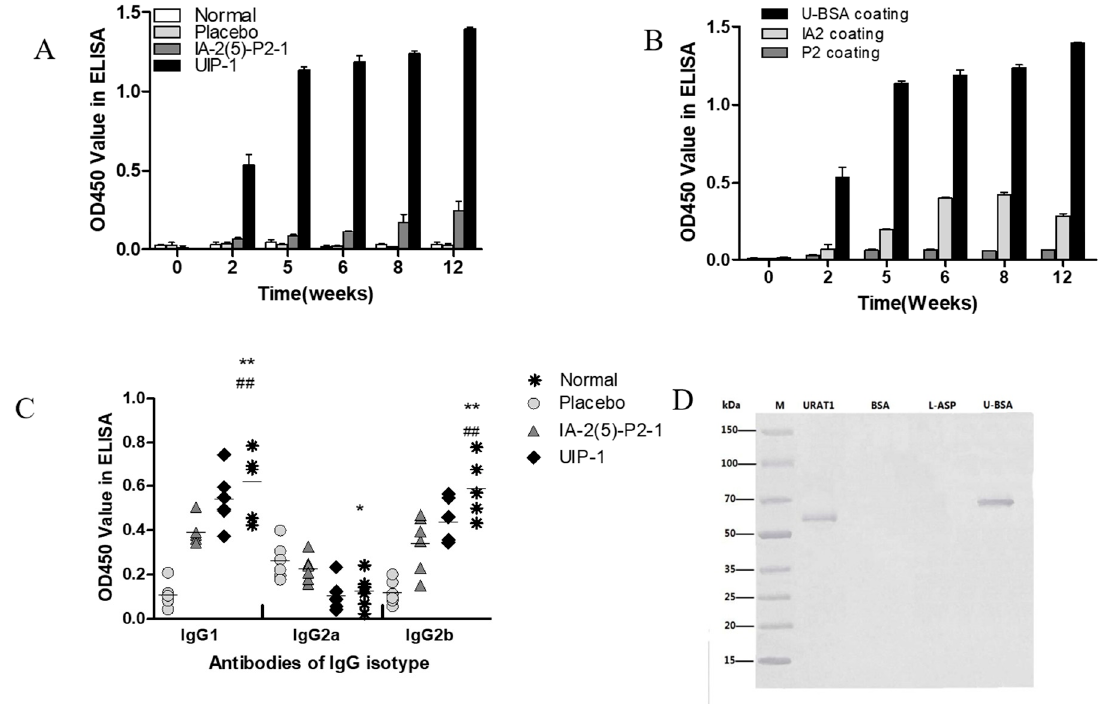
Figure 5. Induction of specific anti-URAT1 antibody after immunization in male C57BL/6J mice. ( A ) Male diabetic mice were immunized with UIP-1 ( n = 10), IA-2(5)-P2-1 ( n = 10), or Lipofundin ( n = 10), as indicated above. The antibody titer is expressed as the mean OD450 value ± SEM; ( B ) Antibodies induced by different epitopes in the multi-epitope peptide UIP-1 were identified using relevant coating antigens in ELISA ( n = 6/10); ( C ) Antibody isotypes induced by the different vaccines were determined by ELISA ( n = 6/10 for each group); ( D ) At week 12, sera were collected from UIP-1-immunized mice. Antibodies that specifically recognized and bound to recombinant URAT1 (lane 1) and BSA-conjugated B-cell epitope peptide (lane 4) were detected by Western blotting. BSA (bovine serum albumin) (lane 2) and Asparaginase (lane 3) were not recognized by the antibodies. All data are expressed as the mean ± SEM. * p < 0.05, ** p < 0.01 (UIP-1 vs. placebo group). ## p < 0.01 (UIP-1 vs. IA-2(5)-P2-1 group).